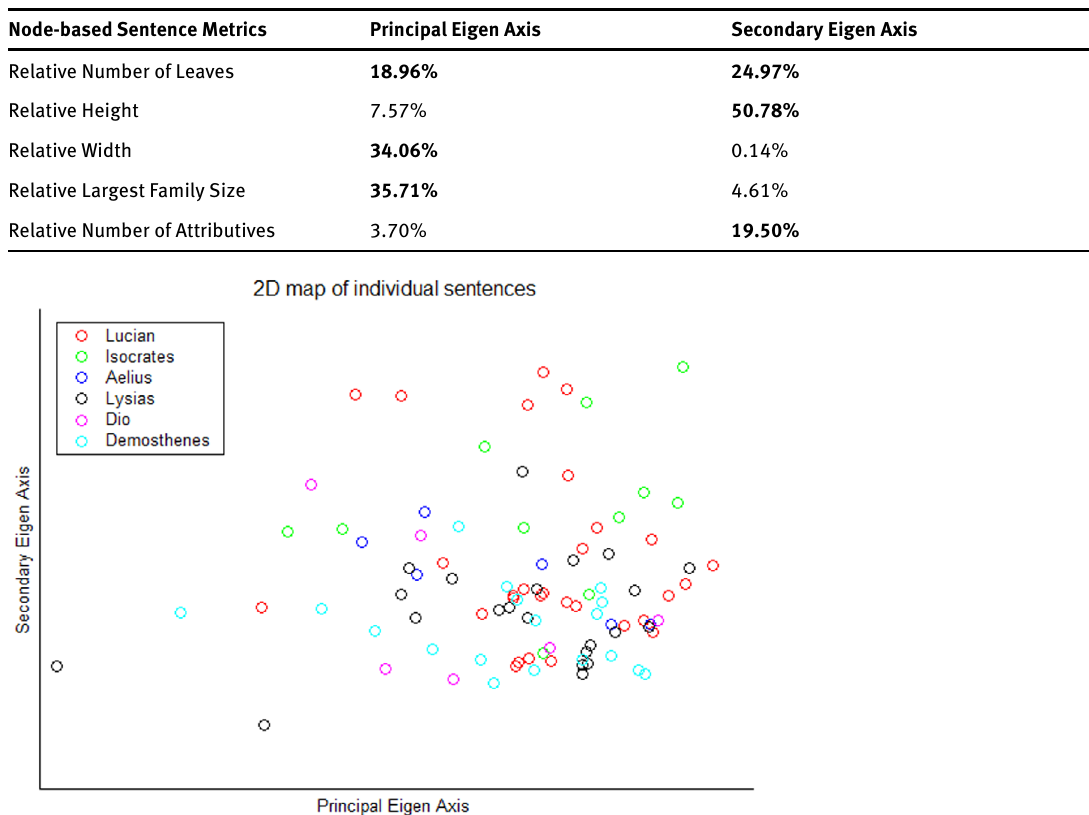
Table 1. The contribution of each metric to the computed Eigen axes